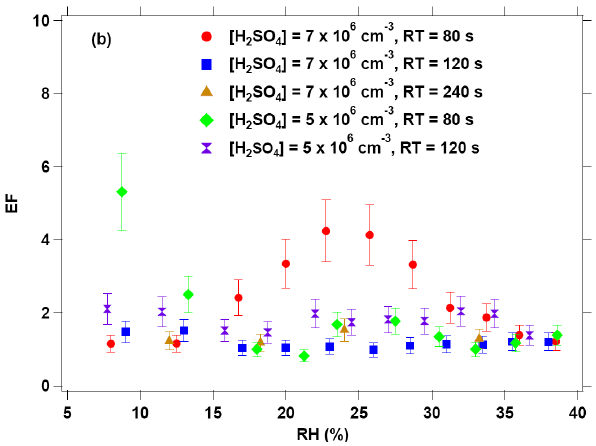
Figure 5a. The measured EF as a function of [H 2 SO 4 ]. [NH 3 ] = 1.22 – 2.6 ppbv. RH = 6 – 16 657 Fig. 5a. The measured EF as a function of [H 2 SO 4 ]. [NH 3 ]=1.22– %. Residence time = 60 – 240 s. 658 2.6ppbv. RH=6–16%. Residence time=60–240s.